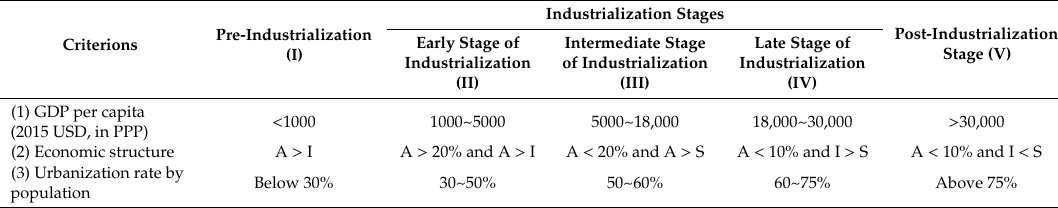
Table 1. Di ff erent industrialization stages and